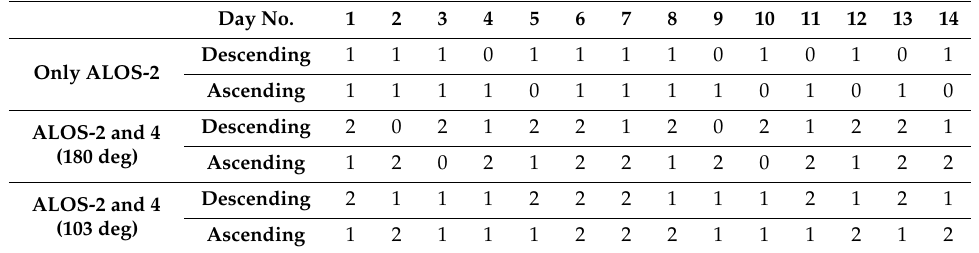
Table 7. The number of observation opportunities using beams 1 to 14 of ALOS-2 for the Joso area, Japan, comparing three satellite configurations: ALOS-2 only, ALOS-2 and 4 with 180 ◦ of separation, ALOS-2 and 4 with 103 ◦ of separation. Day